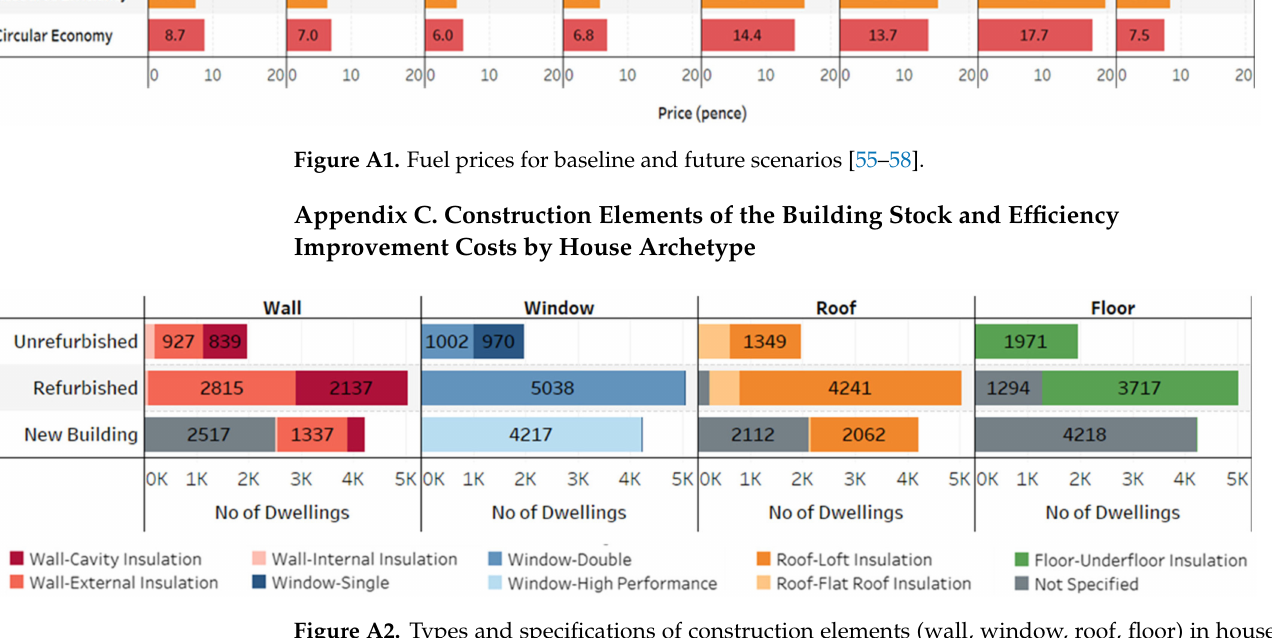
Figure A2. Types and specifications of construction elements (wall, window, roof, floor) in house archetypes and number of houses required energy efficiency requirement.